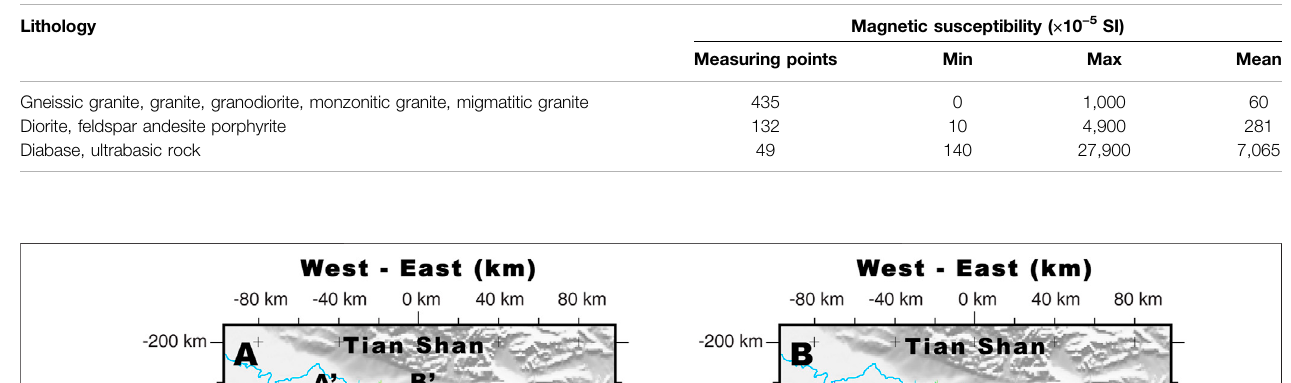
TABLE 2 | Measured magnetic susceptibility of intrusive rocks in the Eastern Tarim Basin.